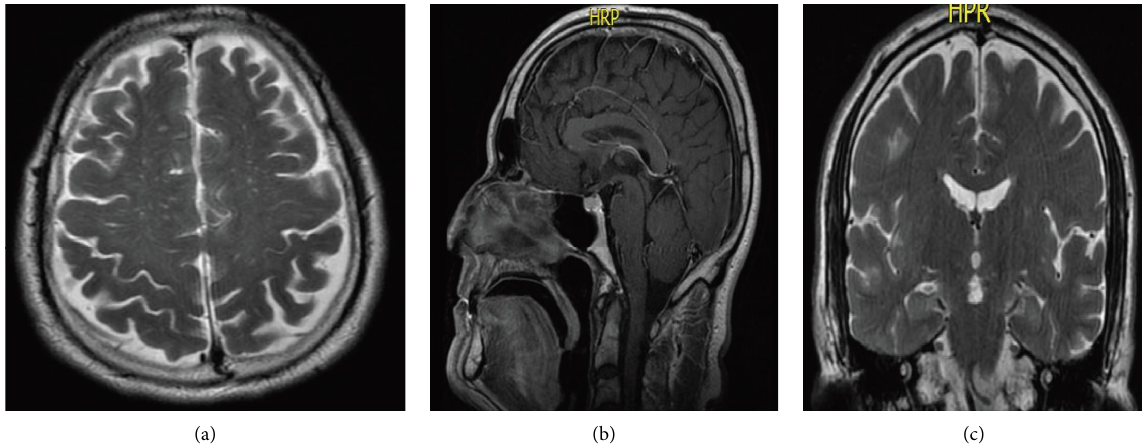
Figure 1: Results of MRI at cortical (a), sagittal (b), and coronal sections at the level of the temporal lobe (c) showing widening of cerebral sulci, subcortical atrophy, and hippocampal atrophy in the patient with advanced Korsakof’s syndrome. Table 1: Assessment protocol that aims at neuropsychological tasks as a function of Korsakof’s syndrome in the patient. Test Description Mini-mental test